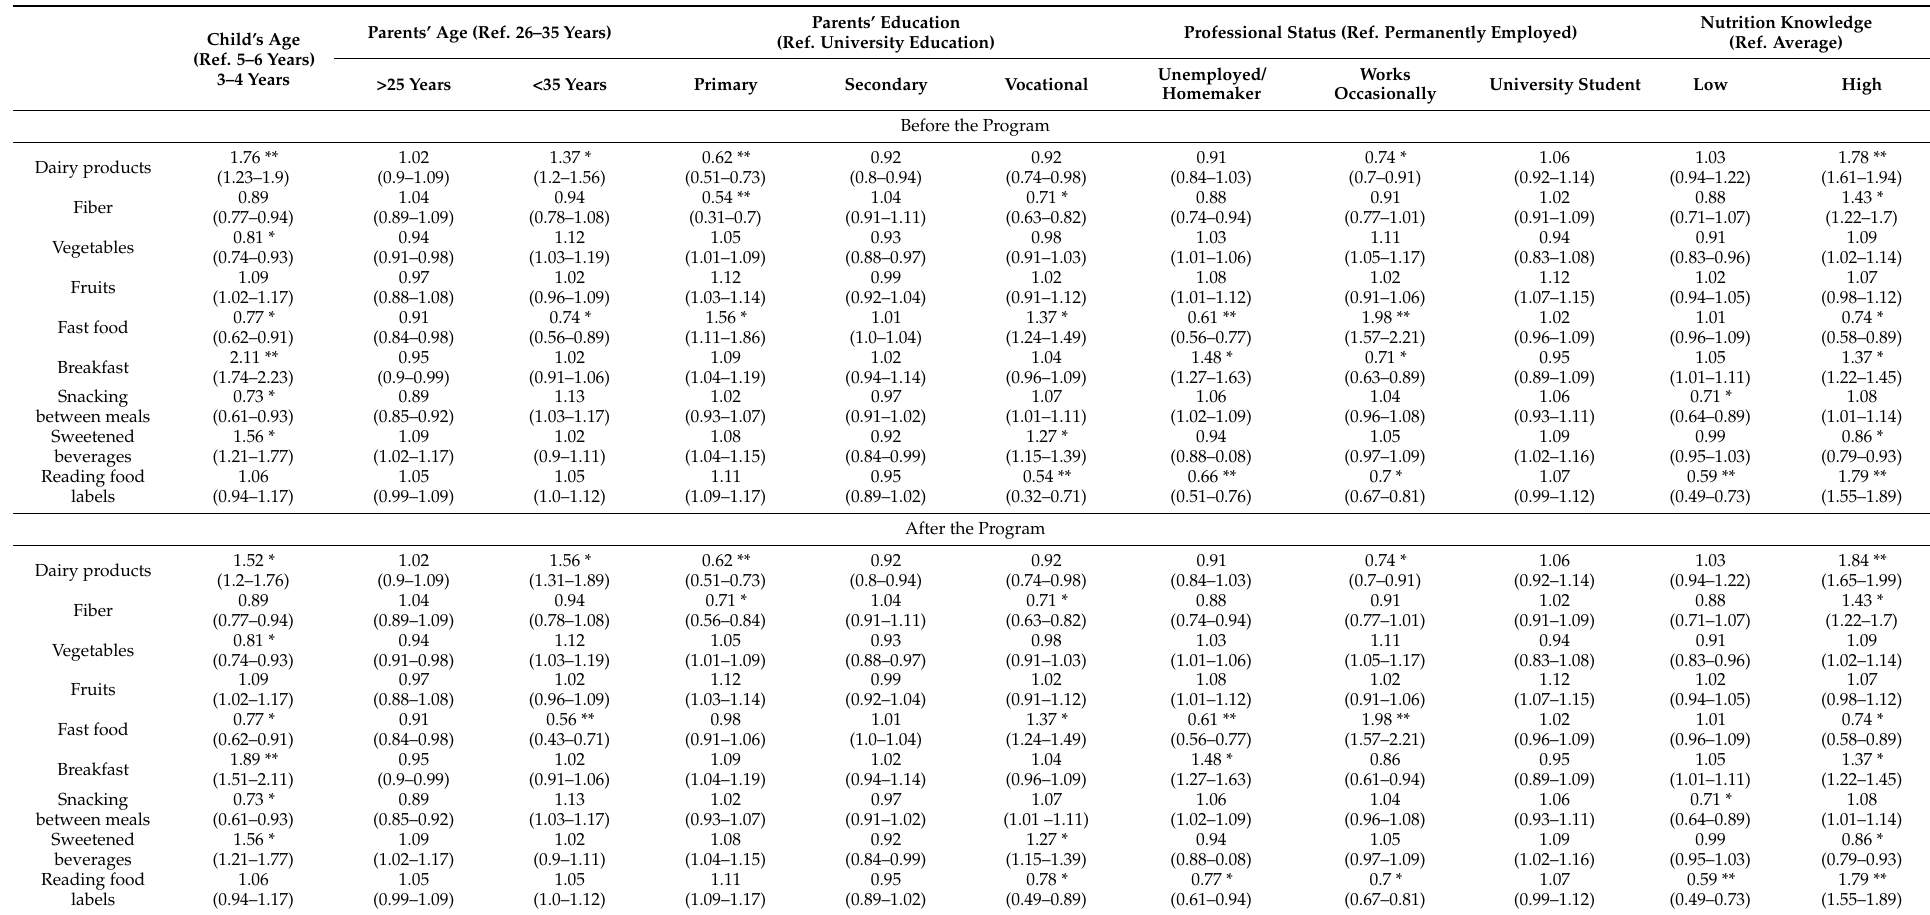
Table 7. Odds ratios (95% confidence interval) in an analysis of the relationships between parental knowledge about healthy eating and the role of nutrition in